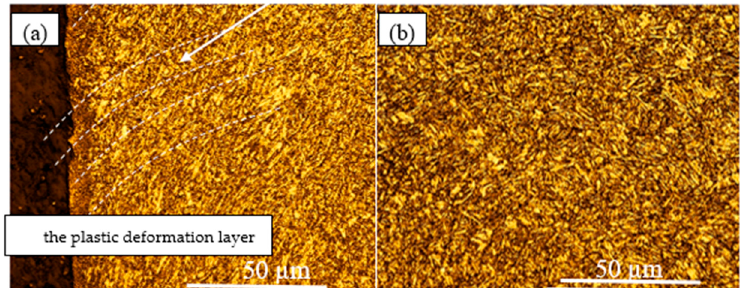
Figure 3. Metallographic structure of AISI 4340 steel: ( a ) Image of the outermost area and ( b ) image of the sample